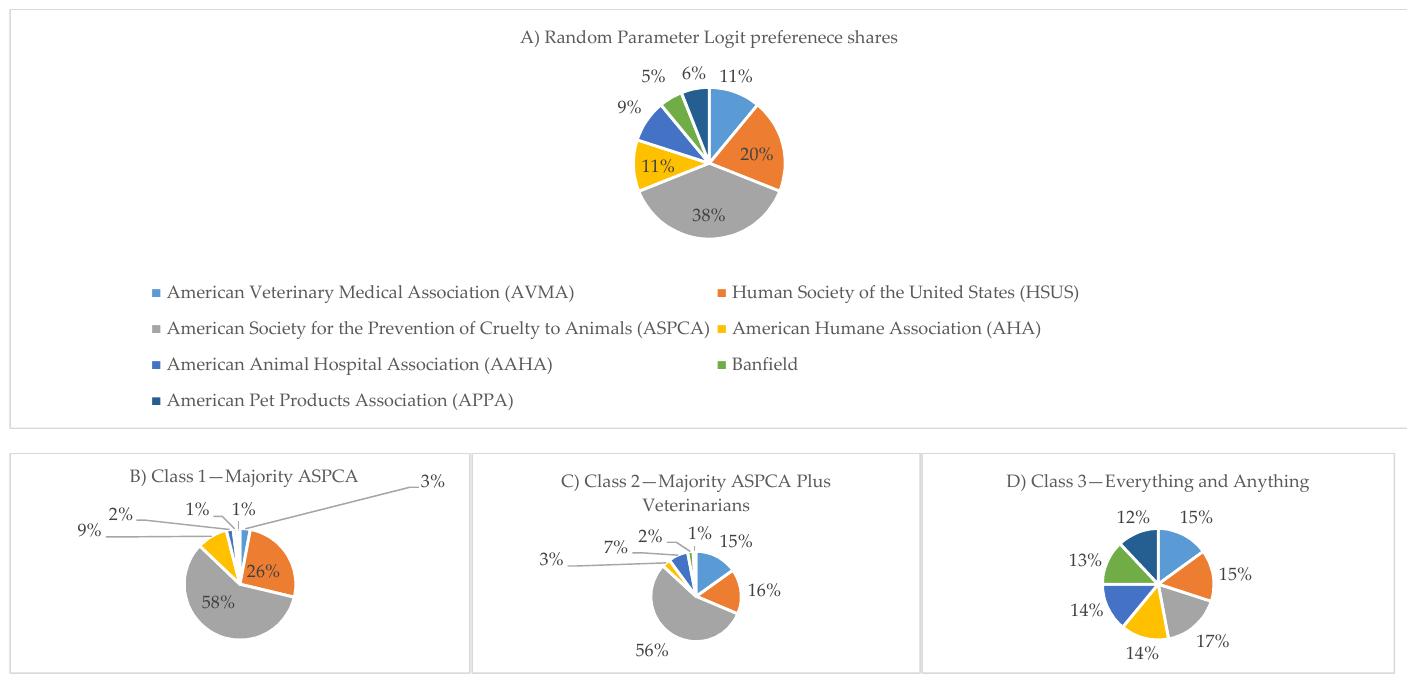
Figure 2. Preference shares of animal welfare organizations determined by ( A ) Random Parameters Logit and ( B–D ) Latent Class Model (n = 1000).